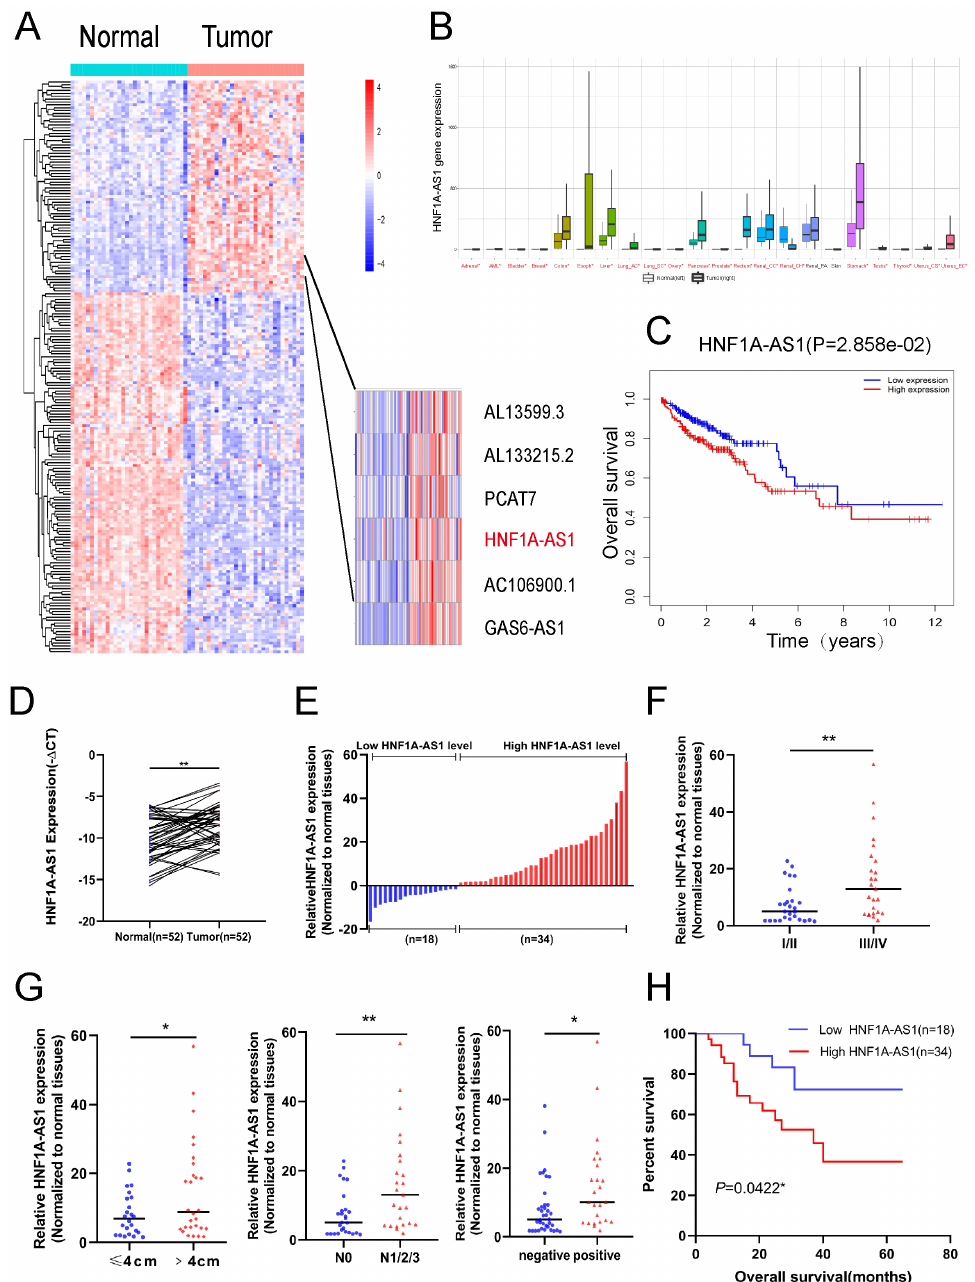
Figure 1. Expression of HNF1A-AS1 in colorectal cancer and its clinical characteristics. ( A ) Heatmap of differentially expressed lncRNAs in CRC patients with stage (III/IV) compared with normal tissues from TCGA-CRC database. ( B ) The overall expression of HNF1A-AS1 in multiple human cancers from TCGA. ( C ) Kaplan–Meier survival curves for HNF1A-AS1 in CRC patients from TCGA database. ( D ) HNF1A-AS1 was highly expressed in CRC tissues ( n = 52) compared with normal tissues through RT-qPCR detection ( − ∆ CT). ( E ) Detailed expression of HNF1A-AS1 was detected in 52 pairs of CRC tissues and classified into relatively high-expression and low-expression group through real-time qPCR. ( F ) Patients with higher pathological stage (III/IV) had higher level of HNF1A-AS1 expression than patients with lower pathological stage (I/II). ( G ) HNF1A-AS1 was higher expressed in patients with large tumor (>4 cm), lymph node metastasis (N1/2/3) or distant metastasis. ( H ) Kaplan–Meier analysis of the survival curves for CRC patients in low HNF1A-AS1 ( n = 18) expression and high HNF1A-AS1 ( n = 34) expression. ** p < 0.01 * p <